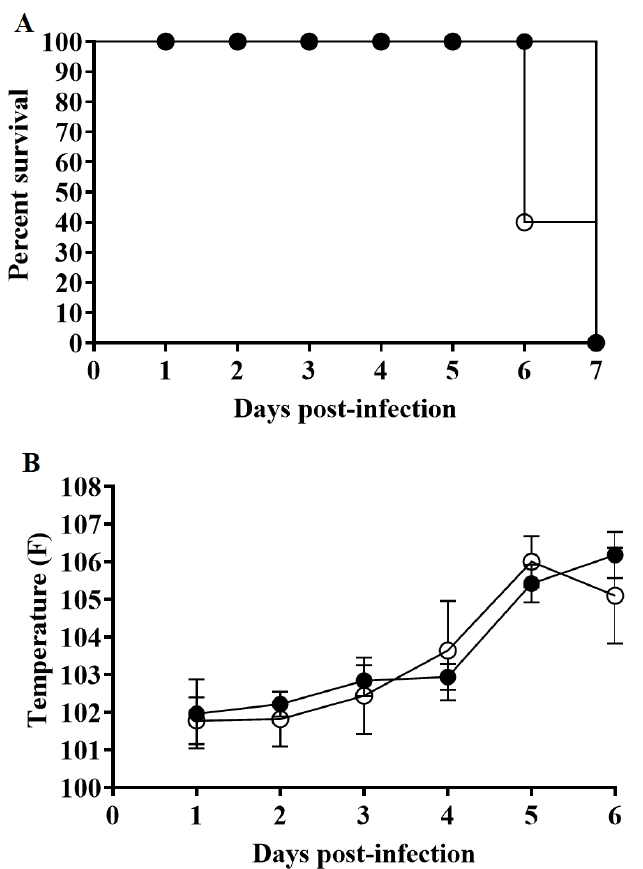
Figure 5. Evolution of mortality ( A ) and body temperature ( B ) in animals (5 animals / group) IM inoculated with 10 2 HAD 50 of either ASFV-G-ΔMGF360-1L (filled symbols) or parental ASFV-G (open symbols). No significant differences in rectal temperatures between groups of pigs are found at any sample time tested using the Holm–Sidak method (α = 0.05) without assuming a consistent standard deviation. All calculations were conducted using the software Graphpad Prism version 8. Viremias in animals IM inoculated with parental ASFV-G showed expected high titers (10 7 –10 8 HAD 50 /mL) on day 4 pi, remaining high until day 7 pi, when all animals were euthanized. Similarly,